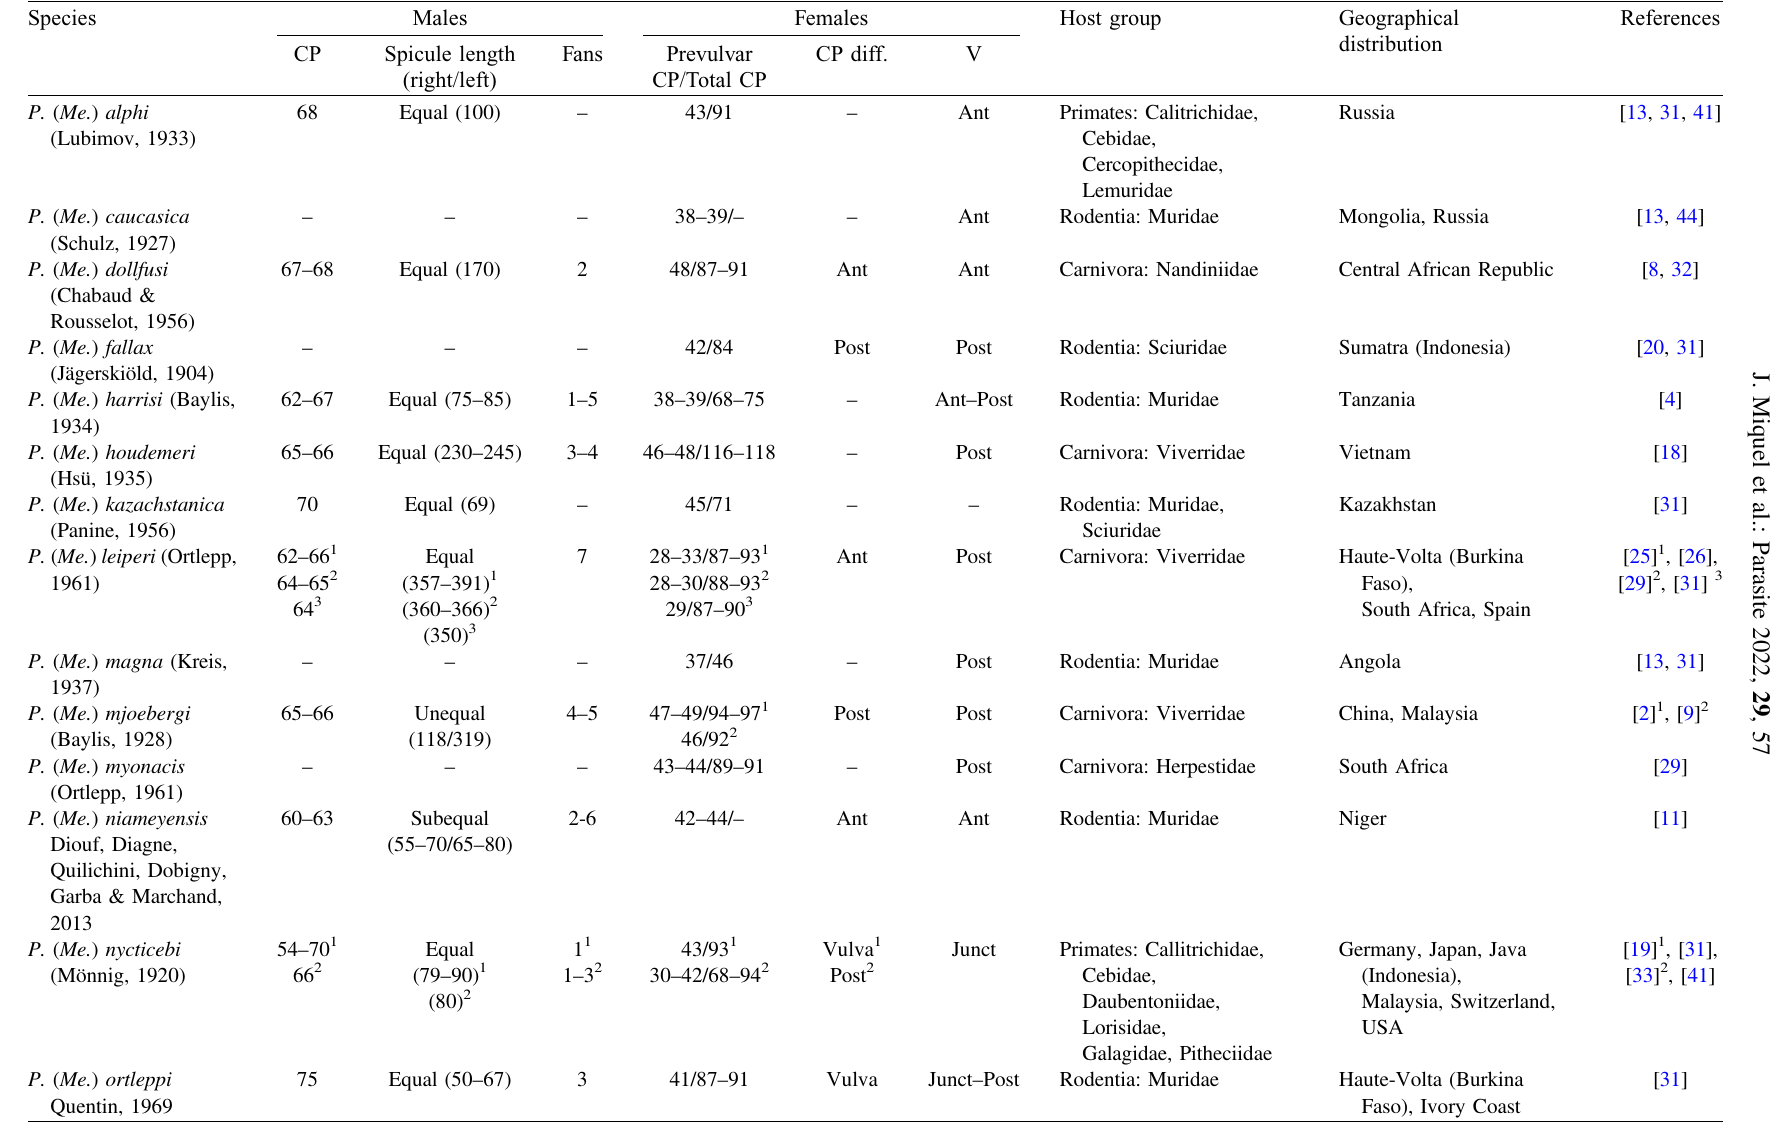
Table 1. Morphological characteristics, host group and geographical distribution of Pterygodermatites ( Mesopectines ) species.